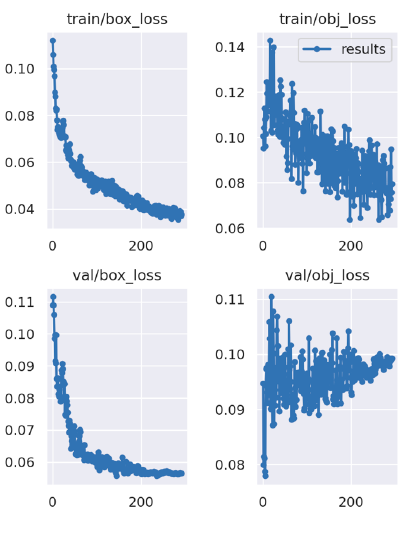
Figure 15. ( a ) Super parameters before modification; ( b ) modified hyperparameters.